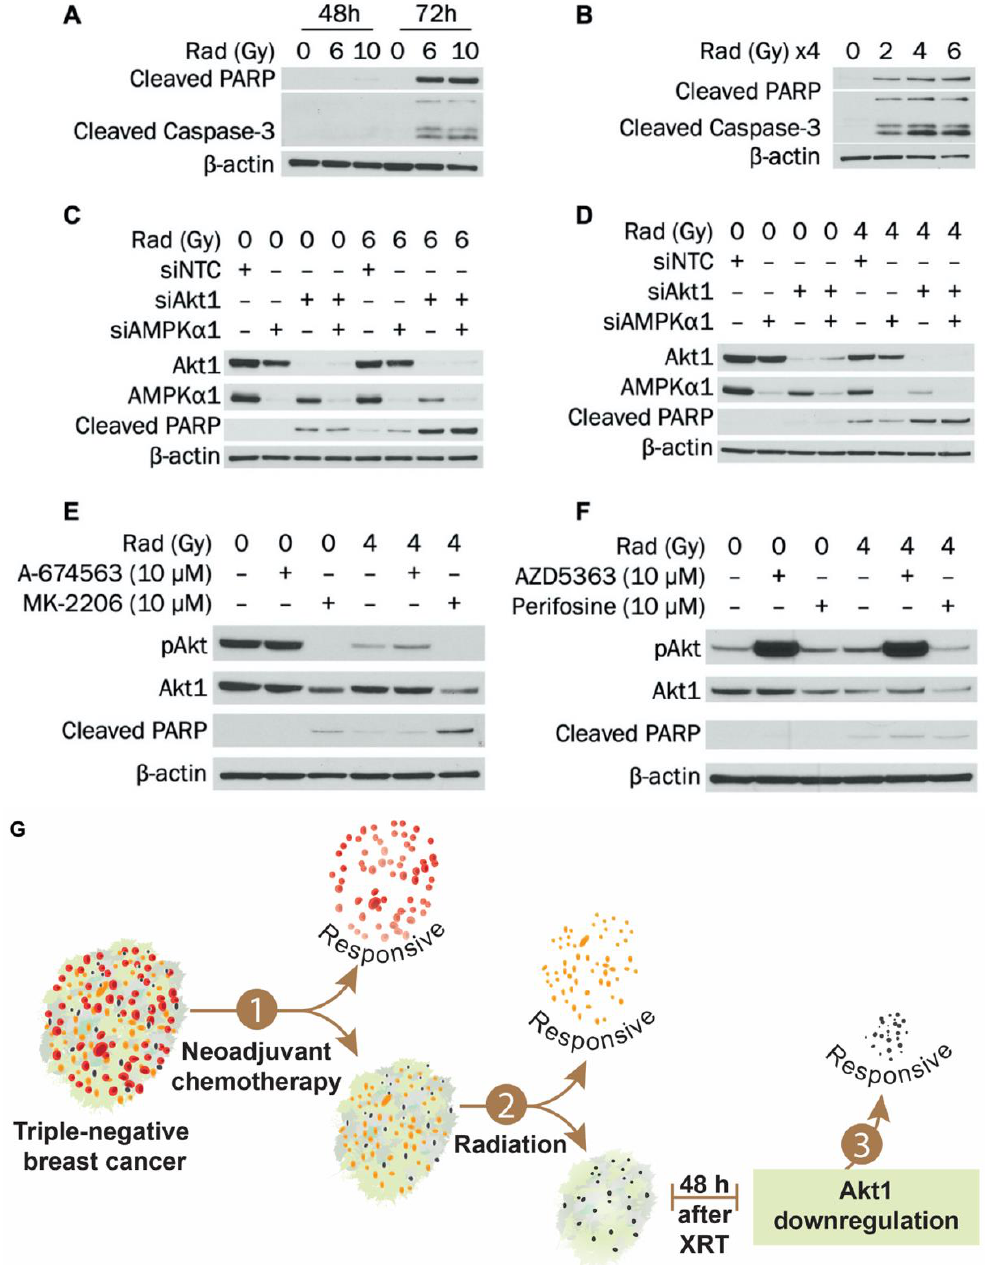
cleavage after 48 h. In Figure 5B, fractionated dosing (2, 4, or 6 Gy daily for 4 d) also led to strong PARP and caspase-3 cleavage after 96 h total in MDA-MB-231 cells.